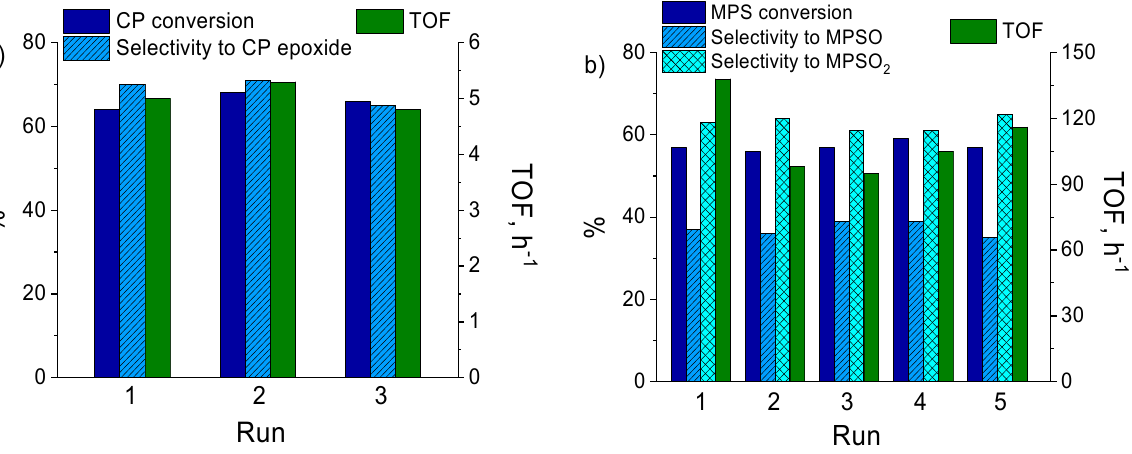
Figure 17. Reuse of sample D in ( a ) CP and ( b ) MPS oxidation with H 2 O 2 . Reaction conditions: ( a ) CP 0.1 mmol, H 2 O 2 (30% aq.) 0.1 mmol, catalyst 20 mg (0.005 mmol Zr), CH 3 CN 1 mL, 50 ◦ C; ( b ) MPS 0.1 mmol, H 2 O 2 (30% aq.) 0.1 mmol, catalyst 5 mg (0.0013 mmol Zr), CH 3 CN 1 mL, 60 ◦ C. TOF = (moles of substrate consumed)/(moles of Zr × time).